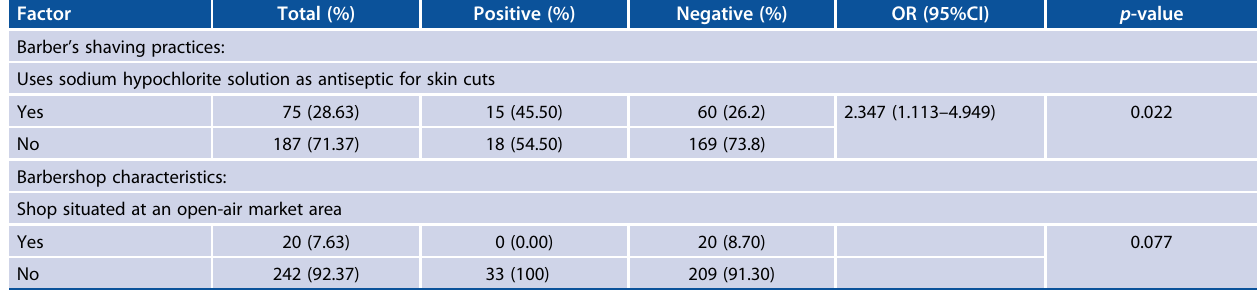
Table 2: Observed shaving practices of barbers and characteristics of barbershops and the risk of HBV infection Factor Total (%) Positive (%) Negative (%) OR (95%CI) p -value